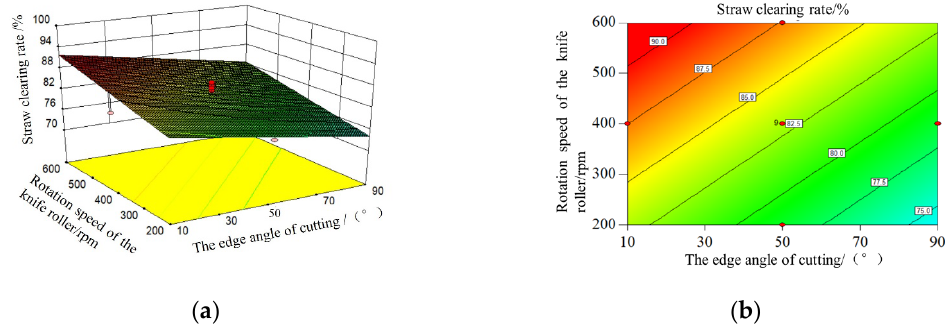
Figure 7. Influence law of each factor on straw clearing rate. ( a ) Response surface diagram. ( b ) Con- tour diagram.